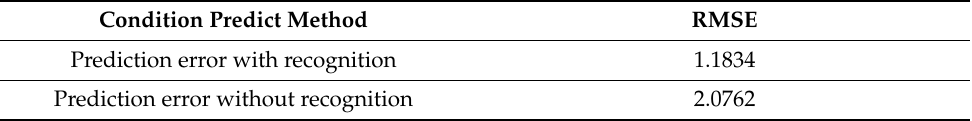
Table 3. Values of